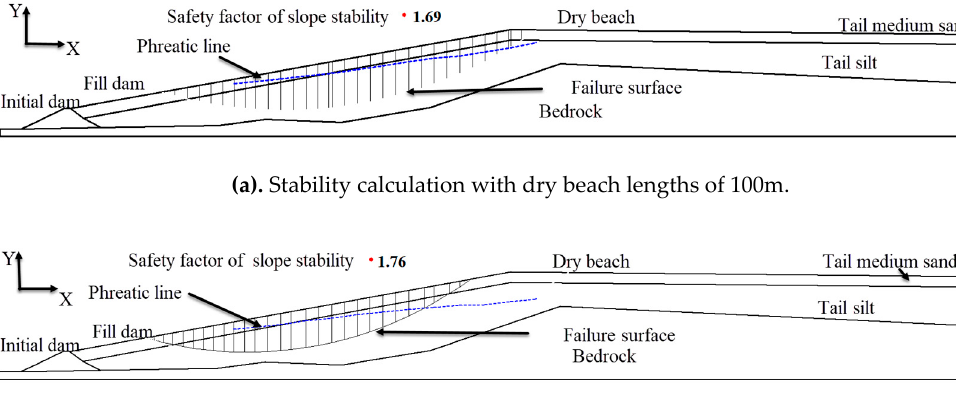
(b). Stability calculation with dry beach lengths of 200m (upstream slope ratio 1:100).